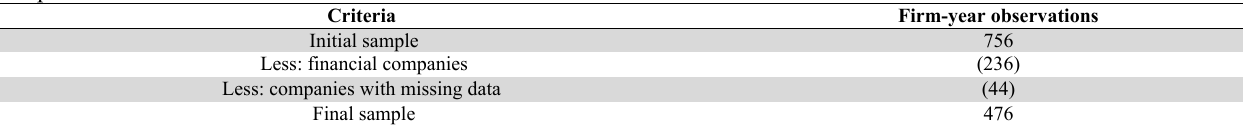
Sample derivation Criteria Firm-year observations Initial